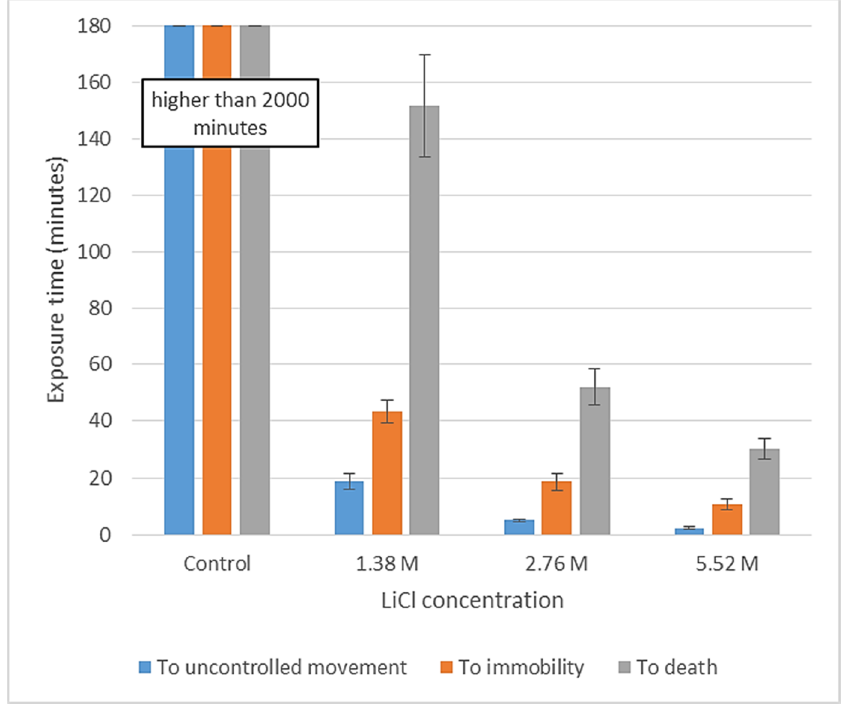
Figure 1. Mean exposure time from immersion to occurrence of an event, with error bars denoting SE (standard error) of the mean, by LiCl concentration. For statistics based on LOG 10 (x+1) transformed data, see Table 2.